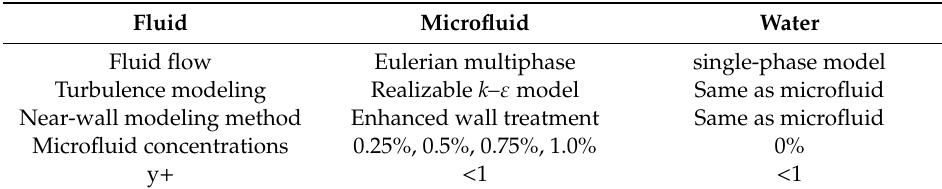
Table 6. Details of the boundary conditions.